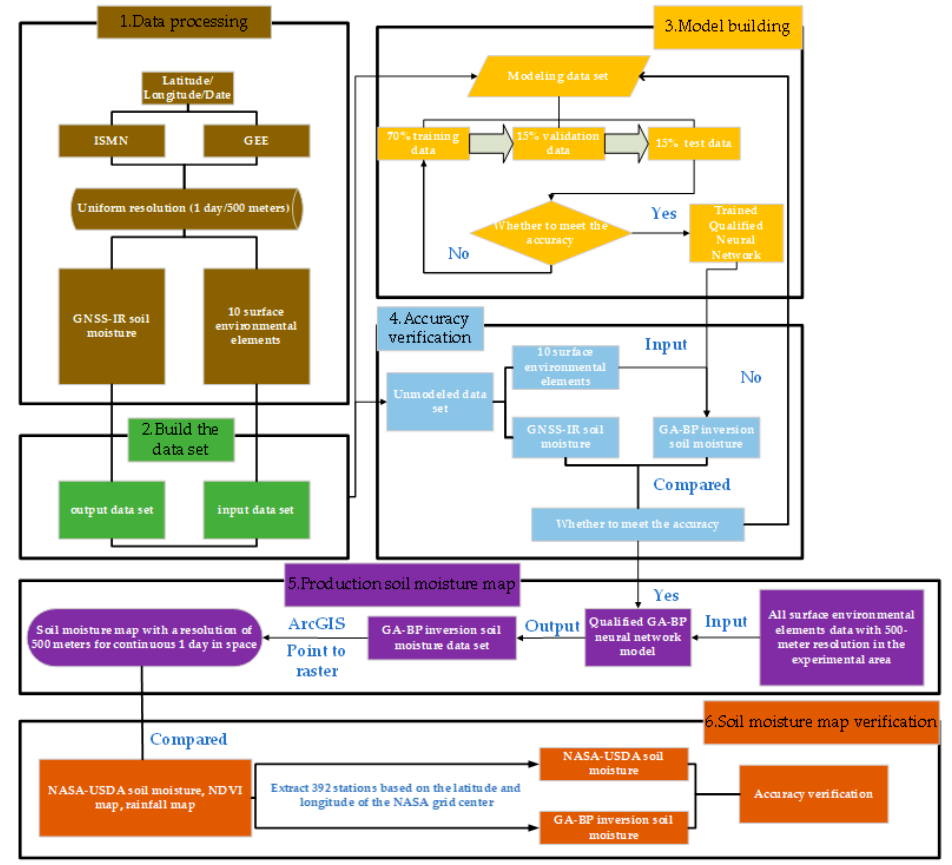
Figure 2. Flow chart of multi-data fusion model.